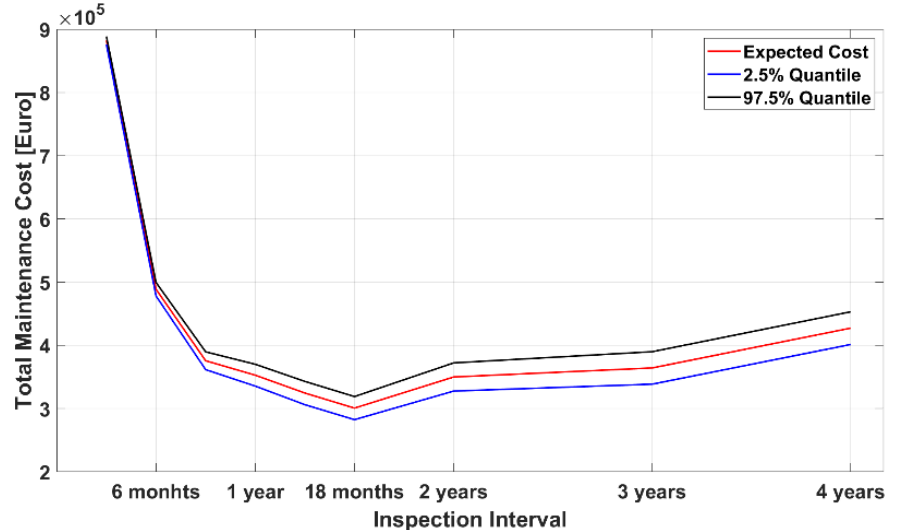
Figure 8. Cost trend as a function of inspection interval of decision alternative 2 with 95% confidence intervals.